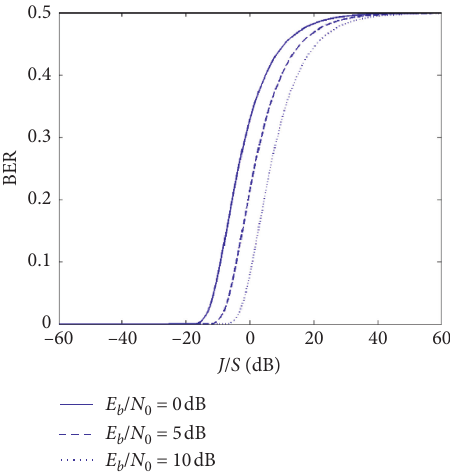
Figure 9: Bit error rate with a variation of J / B